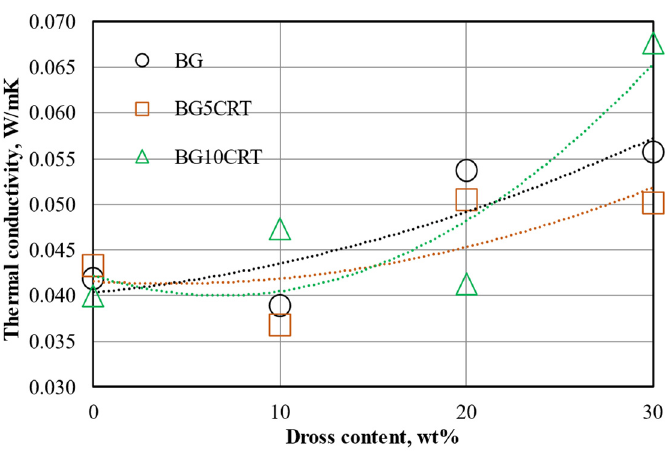
Figure 9. Thermal conductivity of foam glasses.